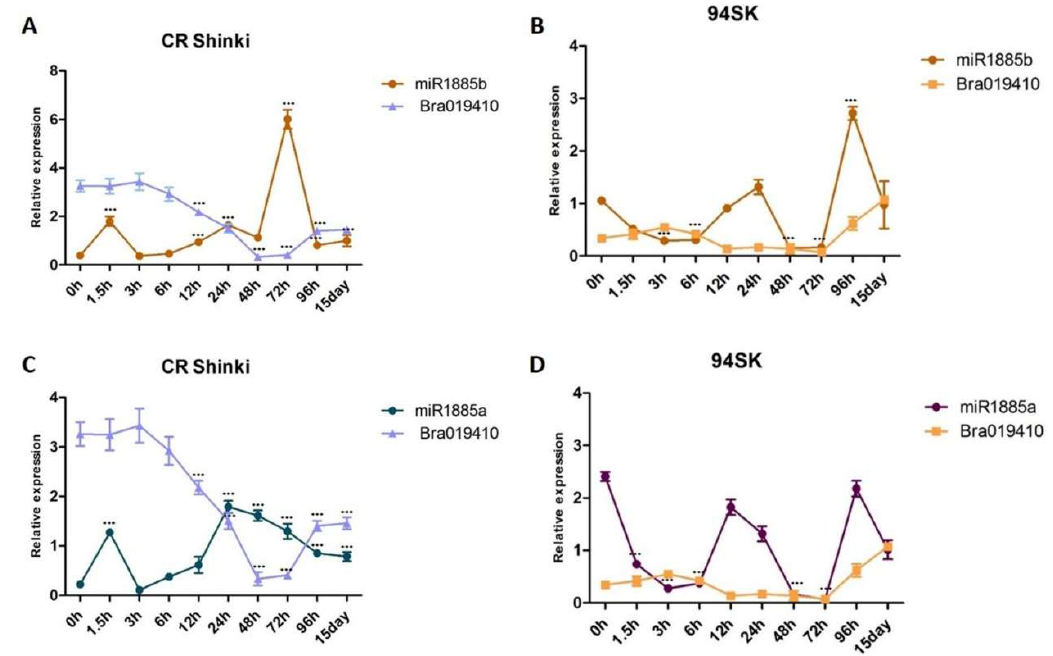
Figure 5. Analysis of the expression of Bra019410 and miR1885b or miR1885a in the root tissues of B. rapa infected with P. brassicae . Correlation of the expression between ( A ) miR1885b and Bra019410 in CR Shinki, ( B ) miR1885b and Bra019410 in 94SK, ( C ) miR1885a and Bra019410 in CR Shinki, and ( D ) miR1885a and Bra019410 in 94SK, as determined by qRT-PCR. The transcript level of the B. rapa actin gene served as the internal control for target gene expression, whereas the U6 snRNA level served as the internal control for mature miRNA expression. The miRNA and gene expression levels, over time, in inoculated plant samples were normalized against the corresponding expression levels in untreated plants. For each time-point, more than six individual plants were pooled ( n > 6) and independent experiments were replicated three times. Standard error bars are presented for each time-point. Asterisks indicate a significant difference at * p < 0.01, ** p < 0.05, and *** p < 0.001.